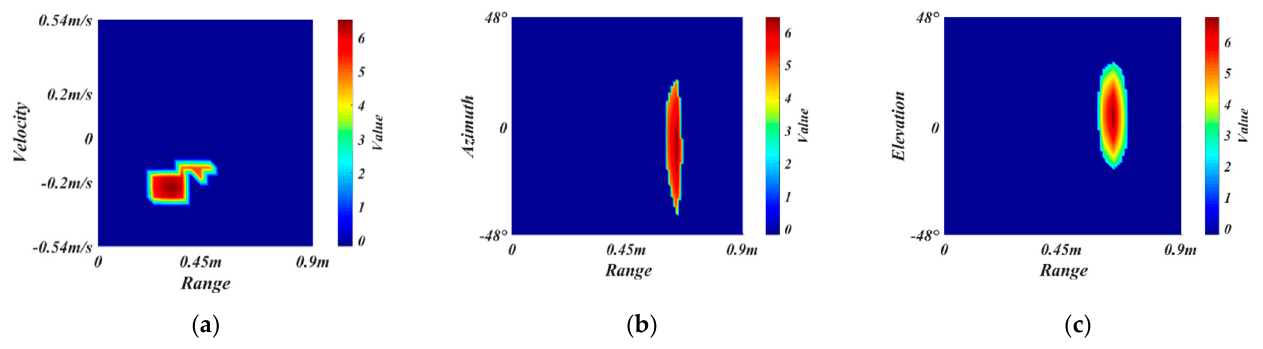
Figure 11. Standardization . ( a – c ) are the standardized RDM, RAM, and REM, respectively.